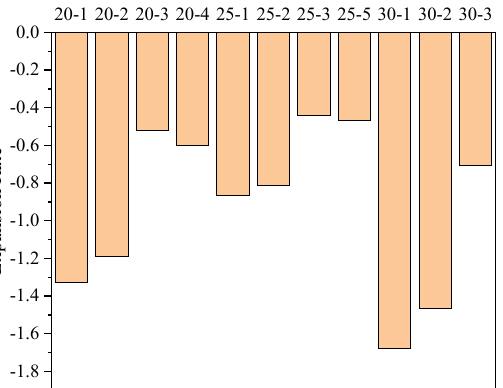
Figure 13. The expansion rates of the specimens cured at a temperature of 20 °C and a humidity of less than 10%.